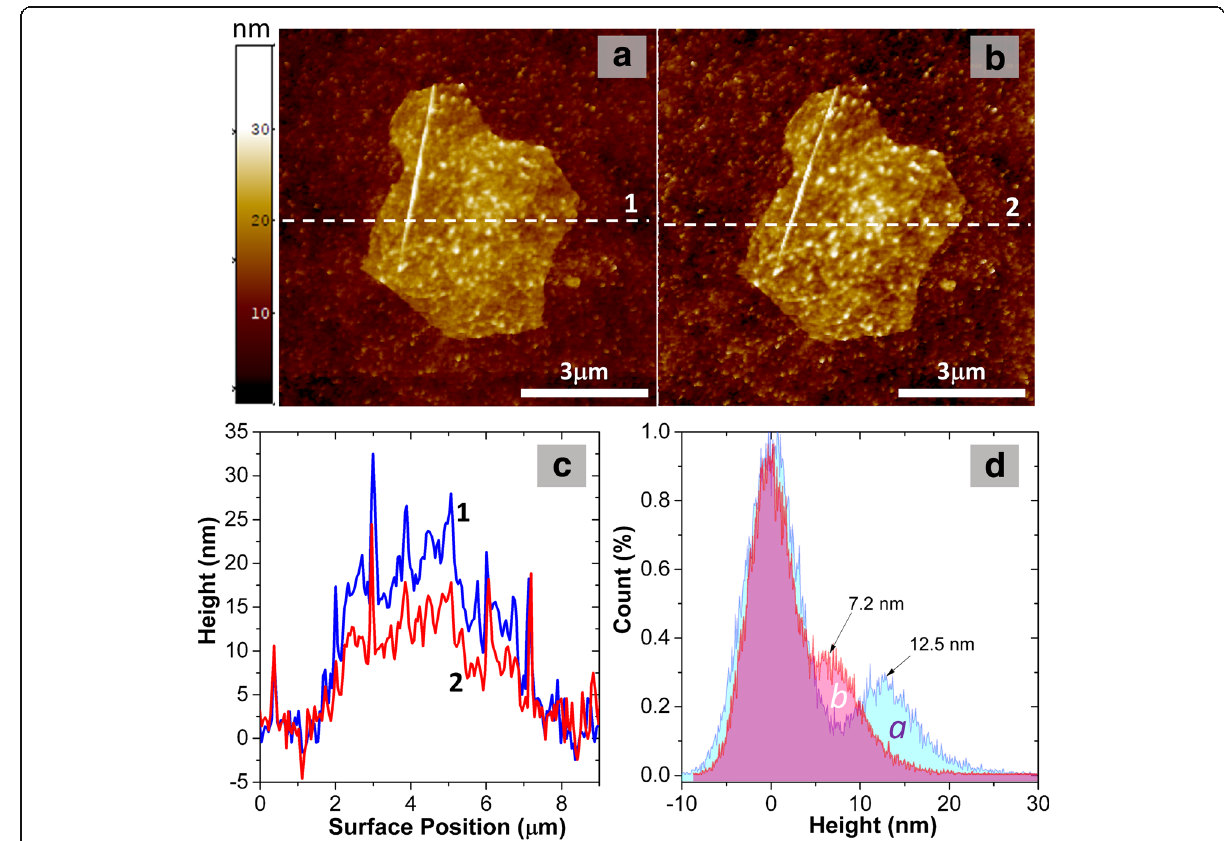
Fig. 7 AFM images of single GO flake on the Ni film: initial ( a ) and annealed at 180 °C for 15 min ( b ). Corresponding surface height profiles along dashed lines are shown in ( c ) and height histograms over images are shown in ( d ). Peaks positions according to the peak-fit analysis are marked by arrows